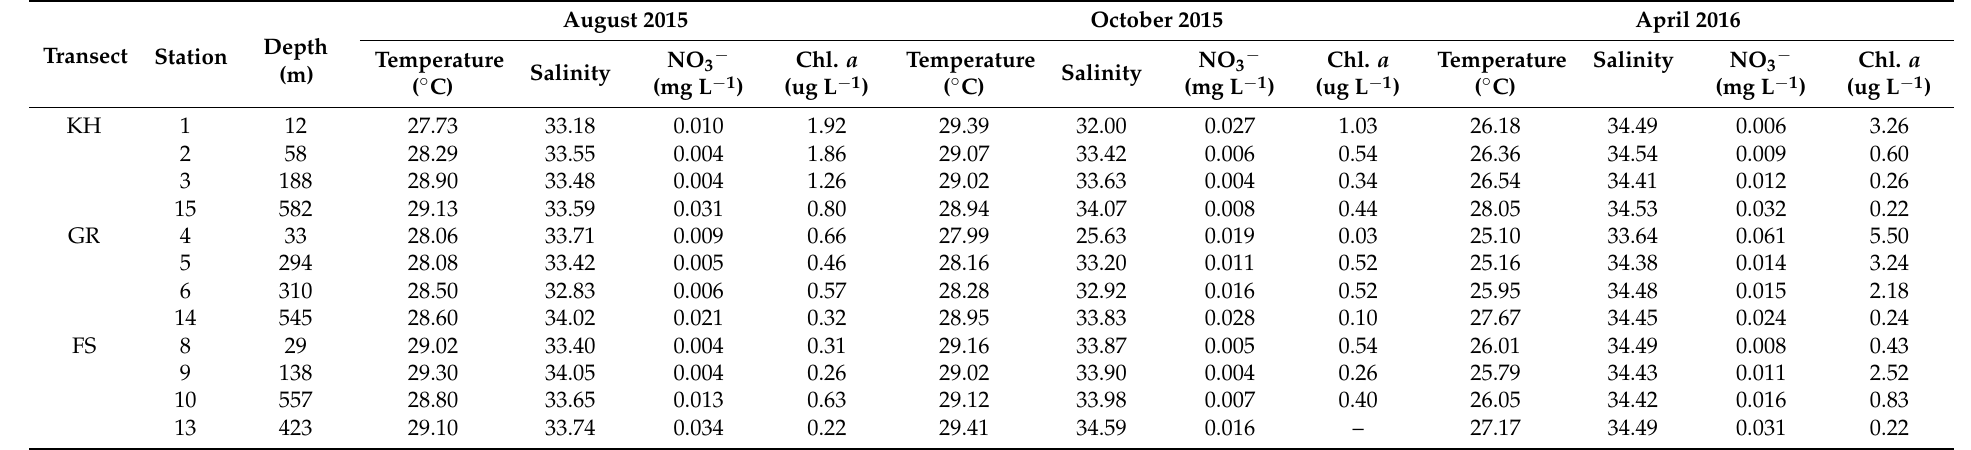
Table 1. Hydrographic variables at the different sampling stations during the study period. KH: Kaohsiung Harbor; GR: Gaoping River estuary; FS: Fengshan Township; –: below minimum detection